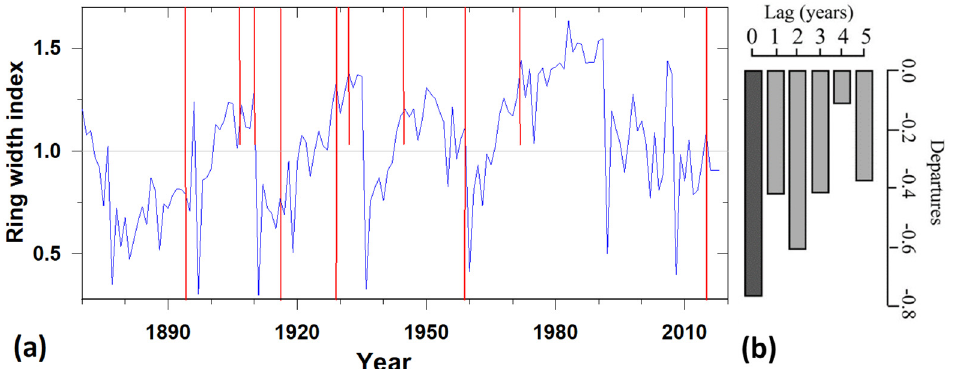
Figure 6. ( a ) The standard annual F. cupressoides tree-ring-width chronology of the Cayutué site during the period of the historical eruption record of the Calbuco volcano from 1850 to 2016 AD. Vertical long and short red lines indicate historical eruptions with a Volcanic Explosivity Index of ≥ 3 and = 2, respectively, according to Petit-Breuilh [51], Sellés and Moreno [50] and the Global Volcanism Program [52]. ( b ) Superposed epoch analysis (SEA) comparing the F. cupressoides normalized treering index departures (z-scores) during the Calbuco eruptions of VEI ≥ 3 for the period 1786–2016 AD. The X -axis represents a set of 6 years (the eruption year and 5 years following it) and black bars represent the significant confidence level at 95% after 1000 Monte Carlo iterations.